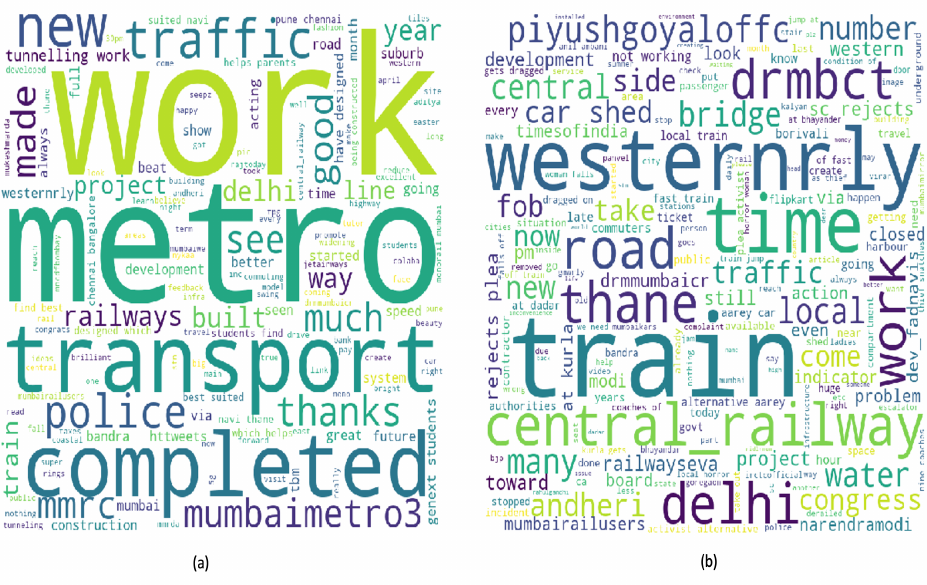
Figure 7. ( a ) Positive word cloud. ( b ) Negative word